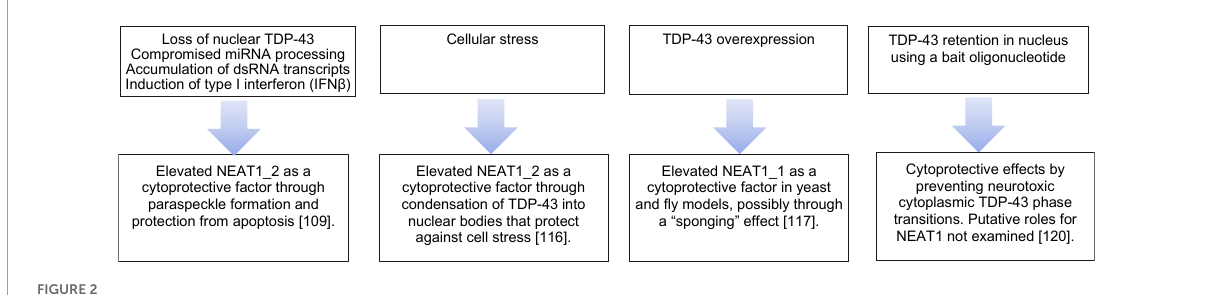
FIGURE2 Cytoprotection associated with transactivation response element (TAR) DNA-binding protein 43 (TDP-43) and nuclear enriched abundant transcript 1 (NEAT1) function. Schematic representation of relationships linking TPD-43 and NEAT1 to protection from toxicity in TDP-43